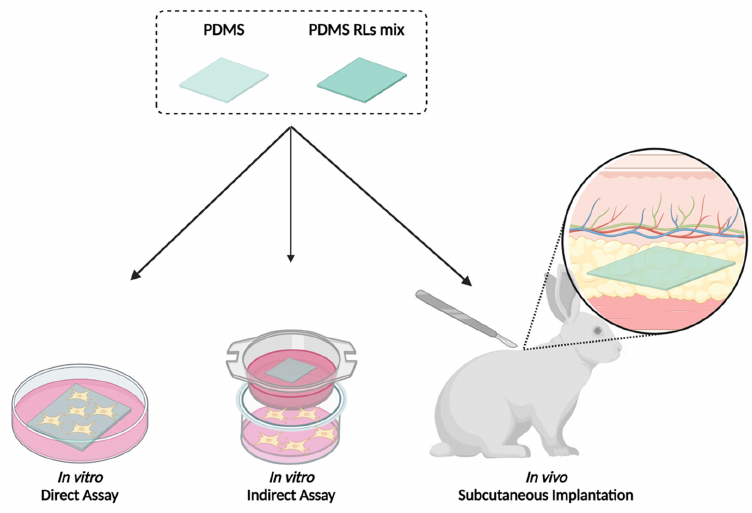
Figure 2. Schematics of the biocompatibility assessment of PDMS materials, conjoining in vitro and in vivo techniques.